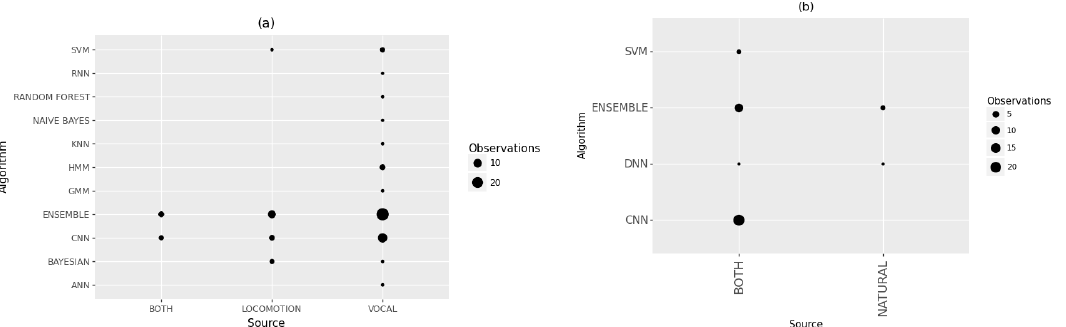
Figure 15. Algorithms used for different sources of sound in ( a ) bioacoustics and ( b ) general acoustics studies.